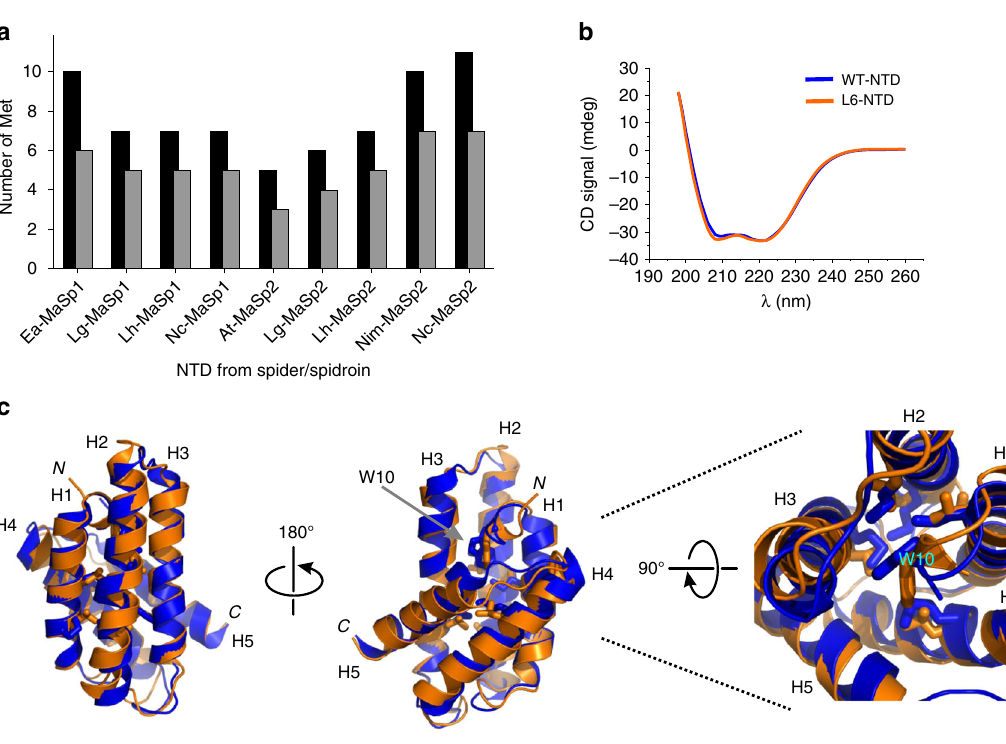
Fig. 1 Met content in spidroin NTDs and solution structure of L6-NTD. a Number of Met residues in homologous, ~135-residue long NTD sequences of MaSp1 and MaSp2 from spider species Ea Euprosthenops australis , Lg Latrodectus geometricus , Lh Latrodectus hesperus , Nc Nephila clavipes , At Argiope trifasciata , and Nim Nephila inaurata madagascariensis (black bars). The number of Met residues in core position and/or involved in tertiary interaction are shown as gray bars. b Far-UV CD spectrum of WT-NTD (blue) and of L6-NTD (orange). c Solution NMR structure of L6-NTD (PDB ID: 6QJY) (orange) aligned with the structure of WT-NTD (PDB ID: 2LPJ) (blue). The side chains of the six Met residues that are in core position and/or involved in tertiary interaction in WT-NTD and are mutated to Leu in L6-NTD are highlighted as blue and orange sticks. The side chain of the conserved Trp (W10), helices 1 – 5 (H1-H5) and N-terminus ( N ) and C-terminus ( C ) are indicated. Source data of Fig. 1b are provided as Source Data fi